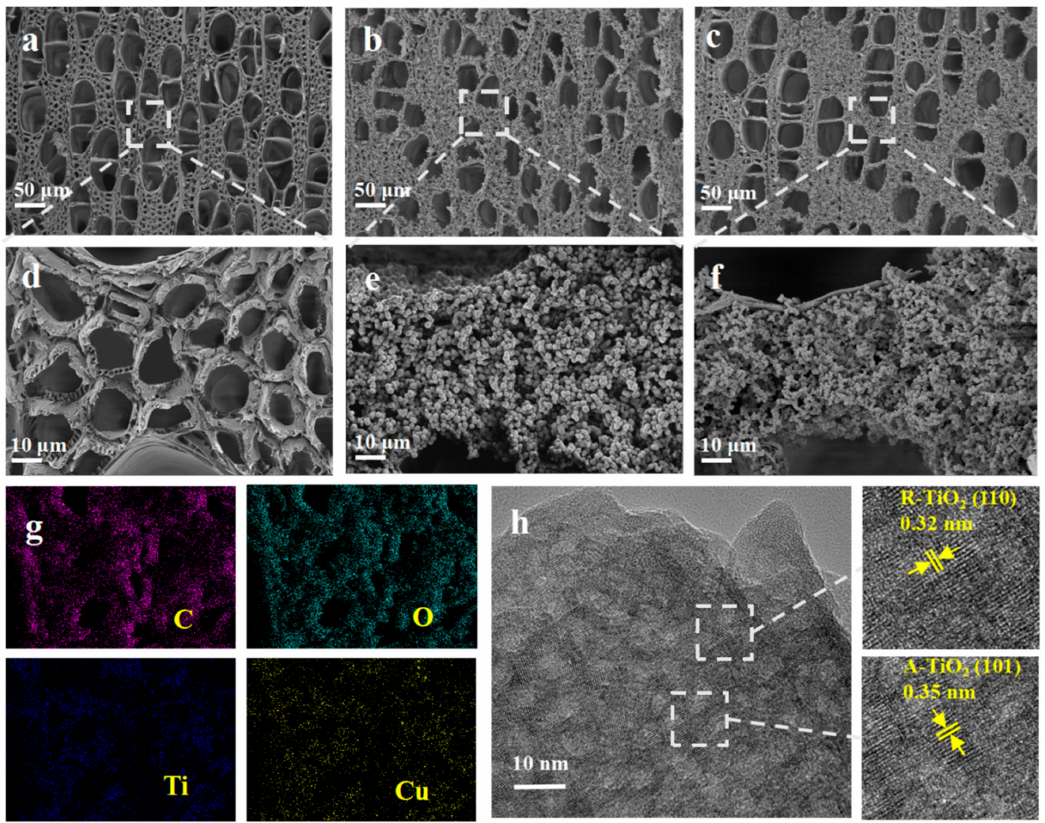
Figure 1. SEM image of the cross-sectional surface of ( a , d ) wood, ( b , e ) TW, and ( c , f ) TWCu7. ( g ) An elemental mapping of TWCu7. ( h ) HRTEM image of the Cu-doped TiO 2